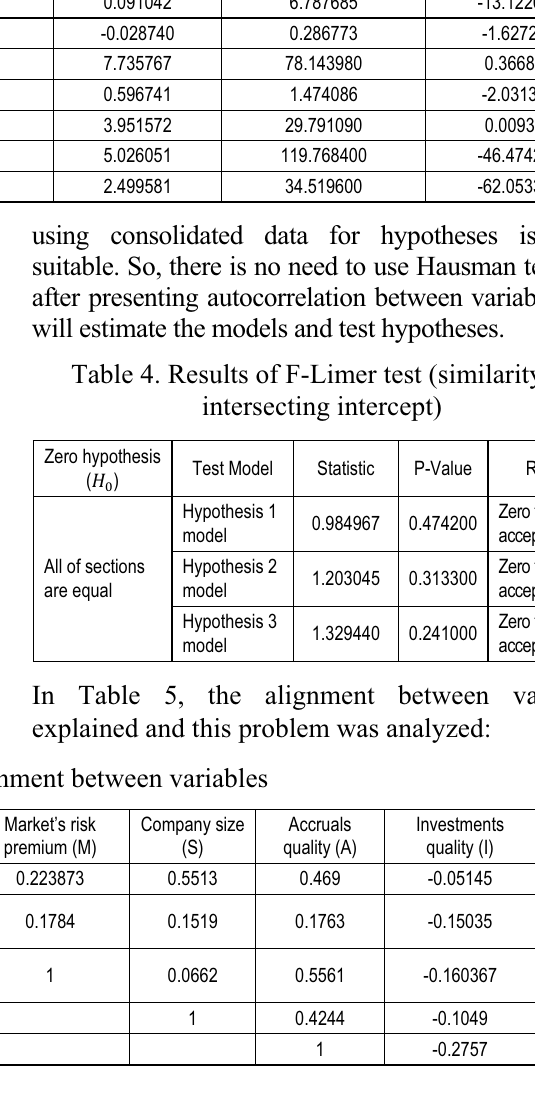
Table 3. Results of descriptive statistics of research variables Variable Variance Average Mean Maximum